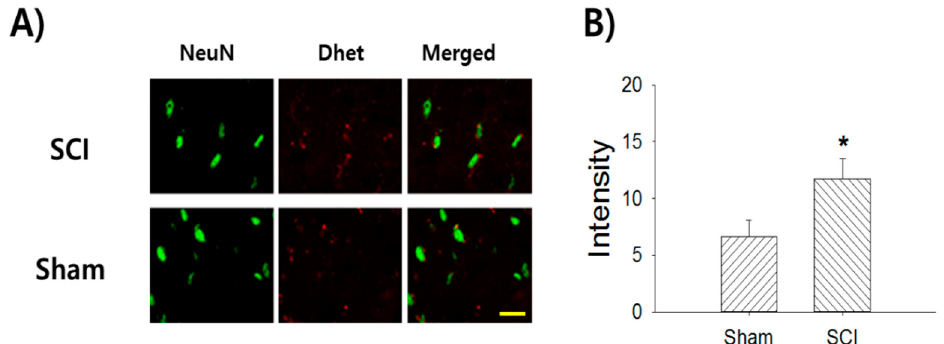
Figure 5. Increase of superoxide production in the thoracic T7/8 spinal dorsal horn after T10 SCI. ( A ) The immunofluoresence staining images represent the neuronal marker neuron (green), superoxide marker Dhet (red), and merged signal, respectively. ( B ) Rats with T10 thoracic spinal cord contusion injury show a significant increase of Dhet intensity in the T7/8 spinal dorsal horn compared to the sham control (* p < 0.05). Scale bar: 50 μ m.